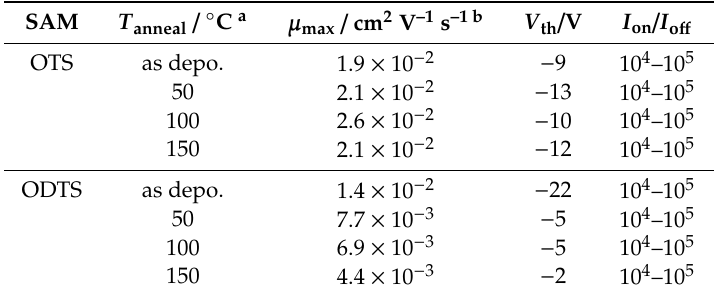
Figure 4. ( a ) Transfer and ( b ) output curves of C6-DNADT-based investigate organic field-effect transistor (OFET). Table 1. OFET Characteristics of C6-DNADT. (Thickness: 50 nm).